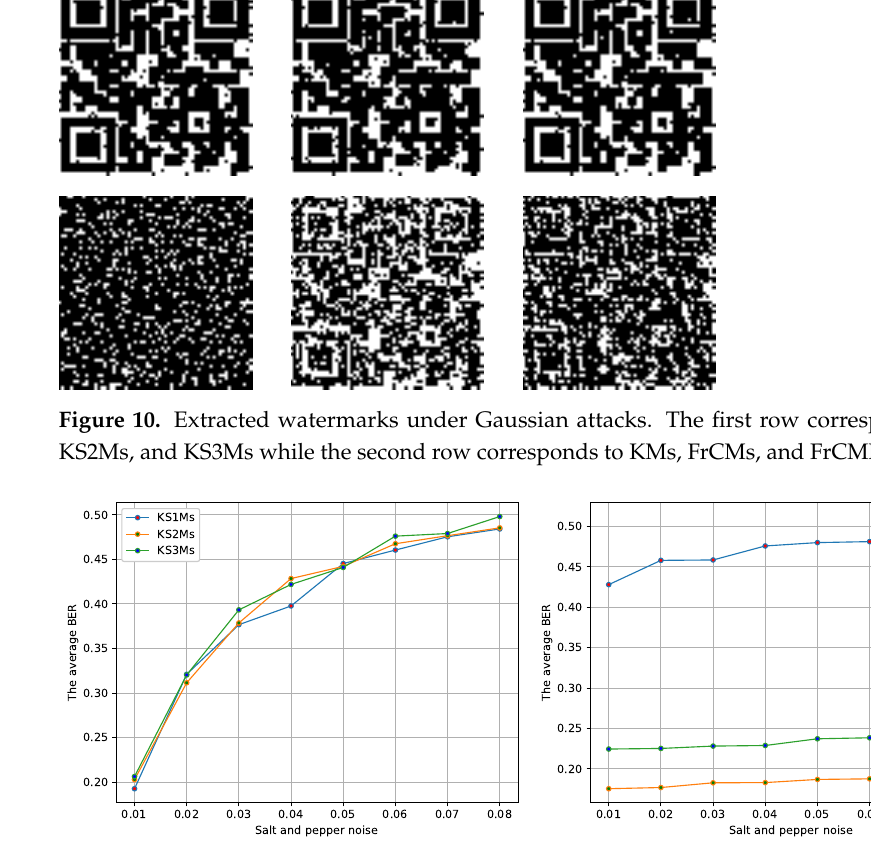
Figure 11. Salt and pepper